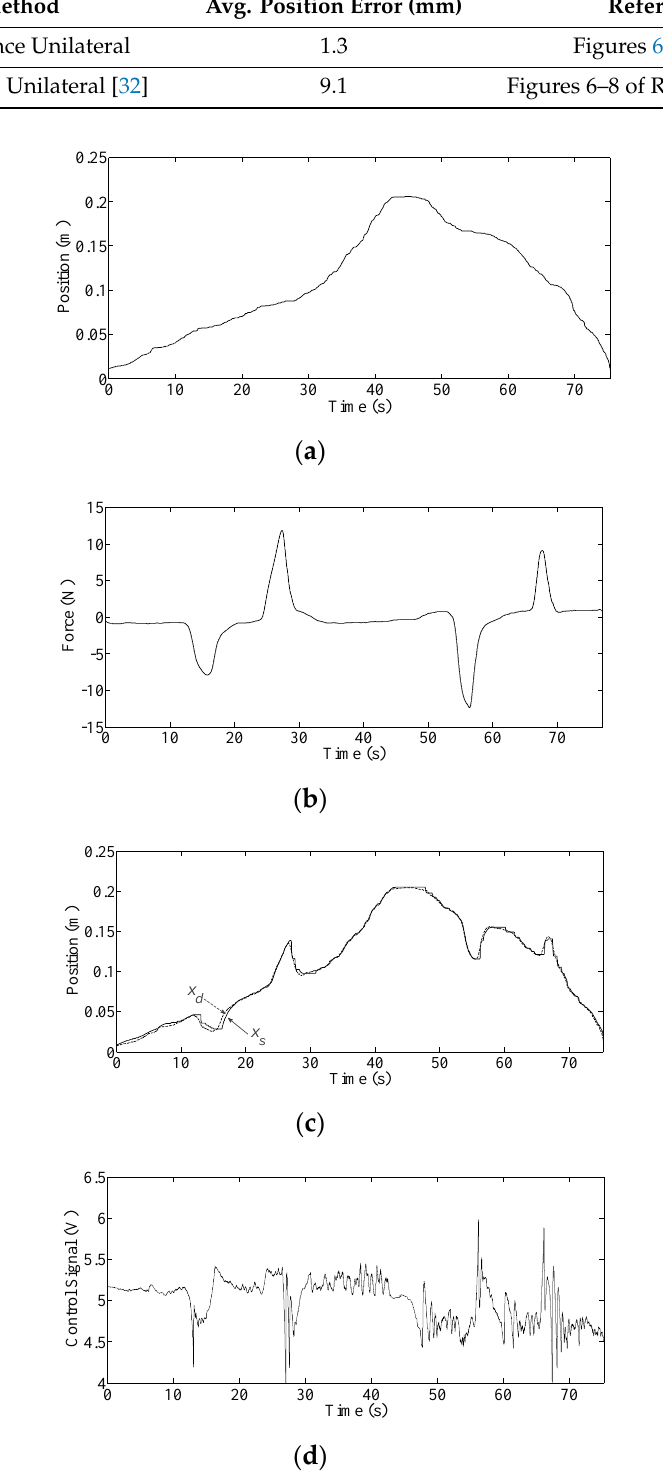
Figure 6. Experimental study of low Stiffness admittance model while tracking a human-guided trajectory: ( a ) primary desired position by master manipulator, x m ; ( b ) external force, F ext ; ( c ) modified desired trajectory, x d , versus position of actuator, x s ; ( d ) control signal, u